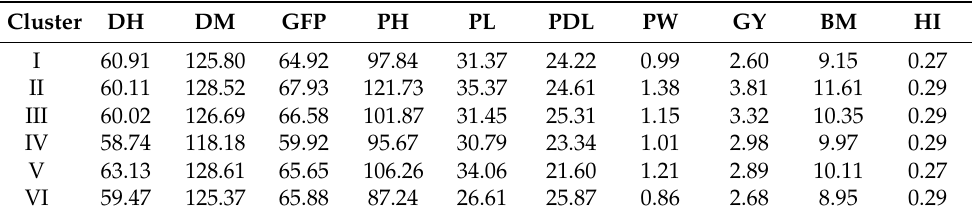
Table 8. Cluster means of grain yield and yield-related traits of teff genotypes under the field growing